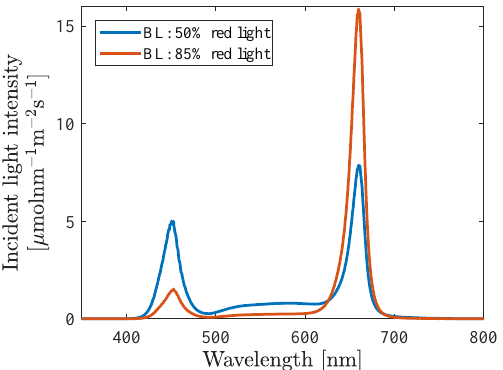
Figure 4. Spectra of background light. Intensity level 500µmolm − 2 s − 1 and spectrum distribution 50% and 85% red light